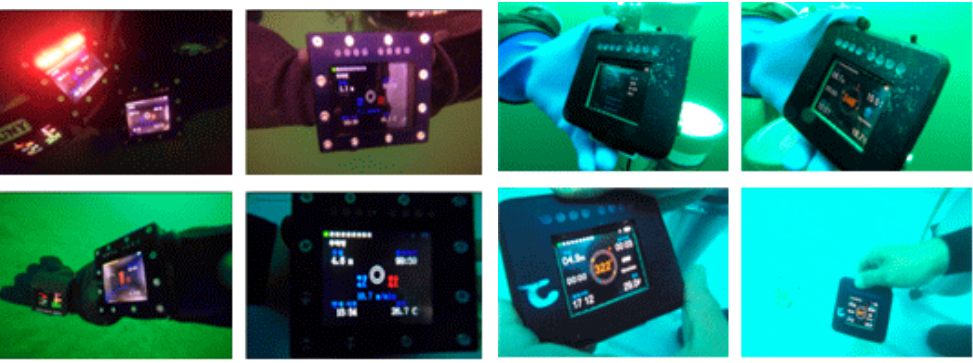
Figure 13. Prototype of DiverPAD.